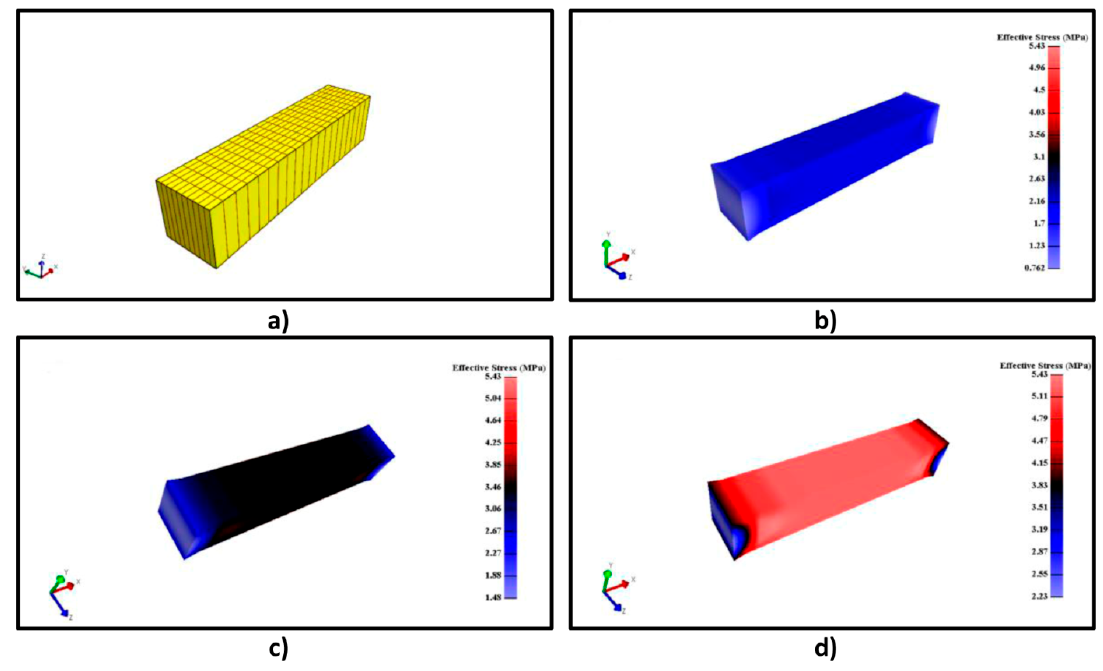
Figure 8. ( a ) Meshed geometry; ( b ) FEM simulation results for A/G 50/50% v / v at 2% w / w ; ( c ) FEM simulation results for A/G 50/50% v / v at 5% w / w ; ( d ) FEM simulation results for A/G 80/20% v / v at 5% w / w .